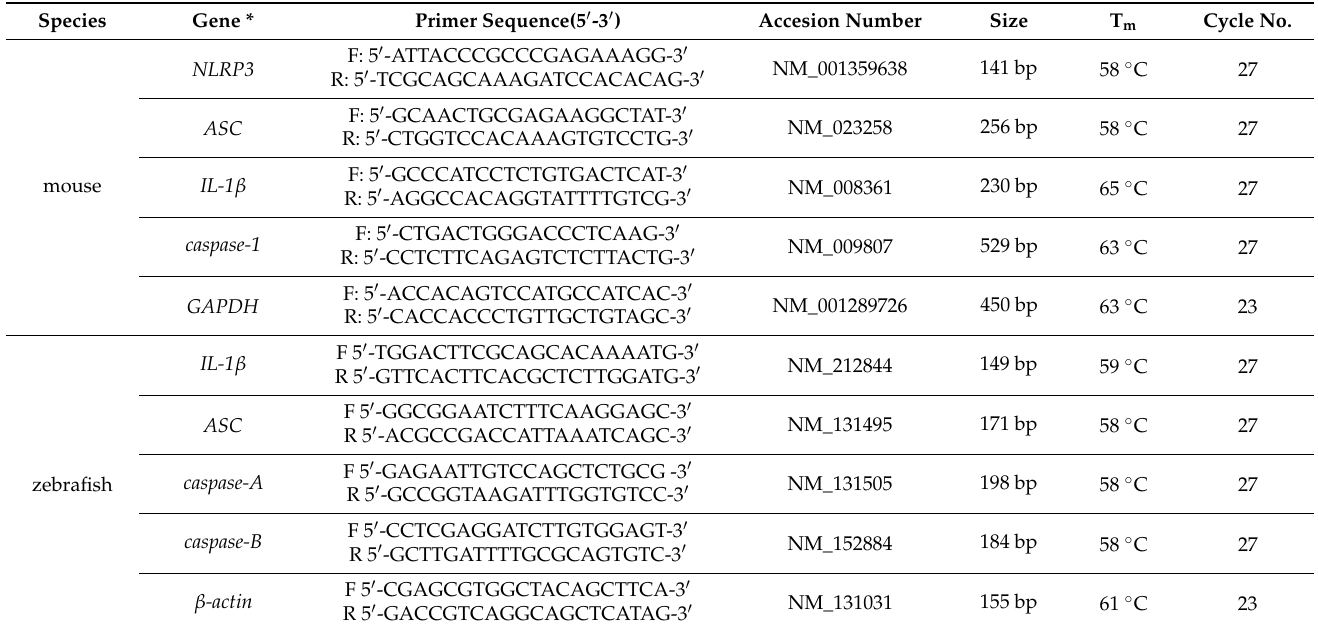
Table 1. Primers and PCR conditions used in this